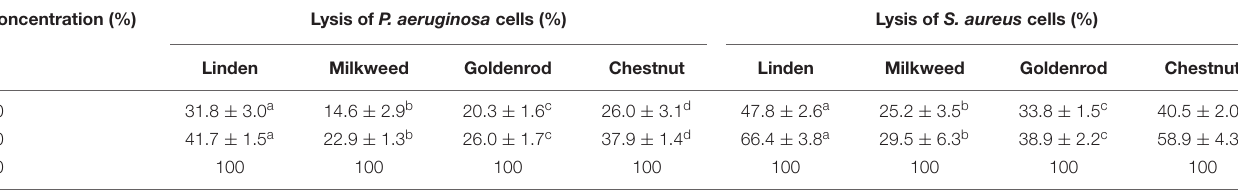
TABLE 5 | The effect of honey solutions at different concentrations on the release of cellular material from P. aeruginosa and S. aureus. Concentration (%) Lysis of P. aeruginosa cells (%) Lysis of S. aureus cells (%) Linden Milkweed Goldenrod Chestnut Linden Milkweed Goldenrod Chestnut